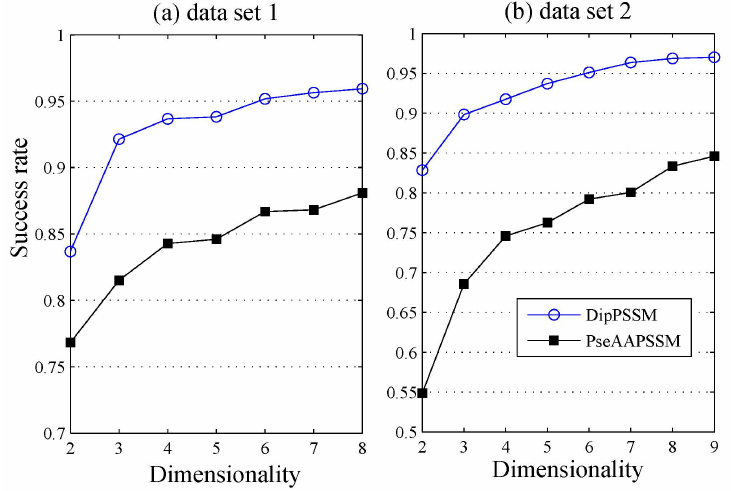
Figure 6. The overall success rates at different dimensions, reduced by LDA, from DipPSSM and PseAAPSSM, respectively: ( a ) Dataset 1 and ( b ) Dataset 2.